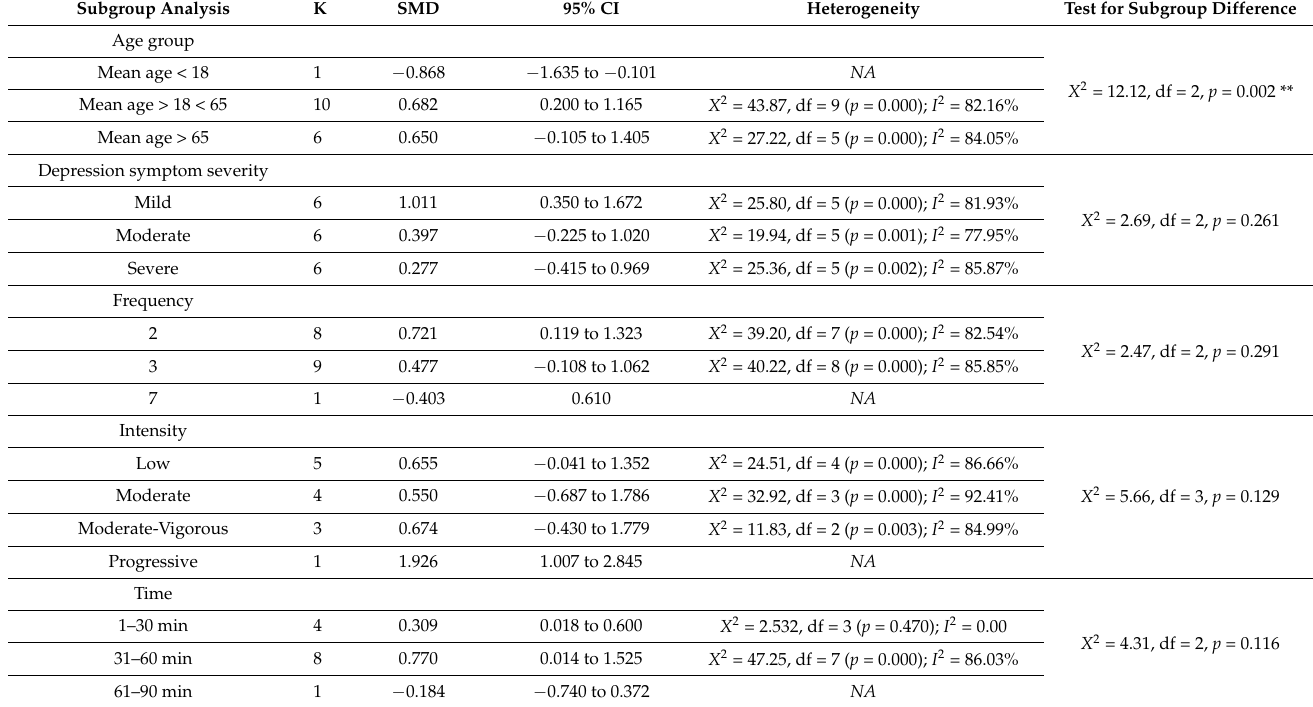
Table 2. The results of the subgroup